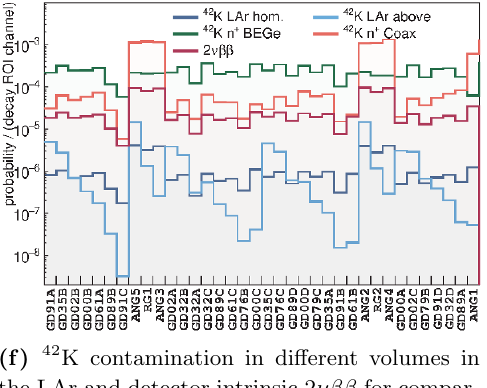
(f) 42 K contamination in di(cid:11)erent volumes in the LAr and detector intrinsic 2 (cid:23)(cid:12)(cid:12) for compar- ison. The energy window (ROI) considered is (1525 (cid:6) 4) keV ( 42 K (cid:13) line).